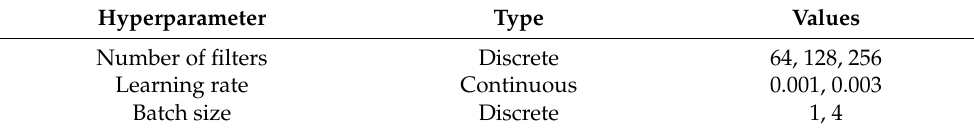
Table 3. Search Space Setup for AHA3D